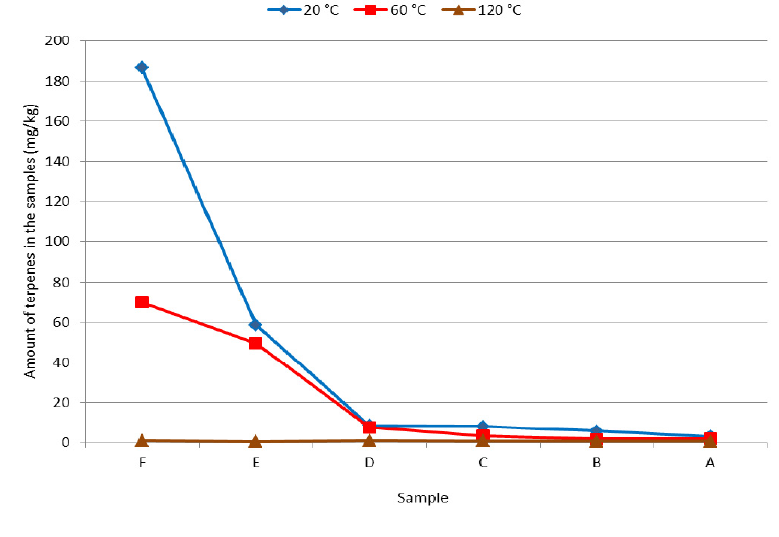
Figure 2. Total quantity of terpenes in original and thermally treated fir wood samples of different ages